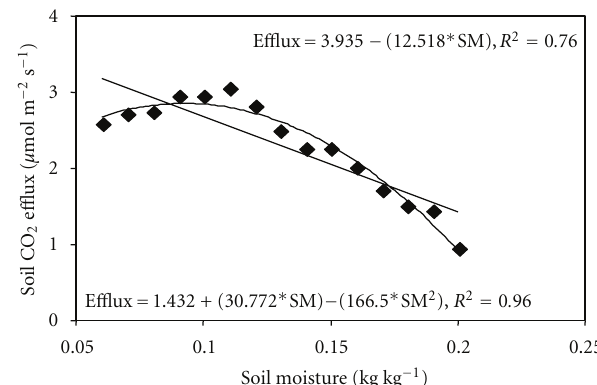
Figure 3: Response of soil CO 2 e ffl ux ( µ mol CO 2 m − 2 s − 1 ) to soil moisture for ambient (365 µ mol CO 2 mol − 1 ) CO 2 plots only in a model regenerating longleaf pine-wiregrass ecosystem. Equations describing this line, with fit statistics, are provided above (linear) and below (quadratic) the